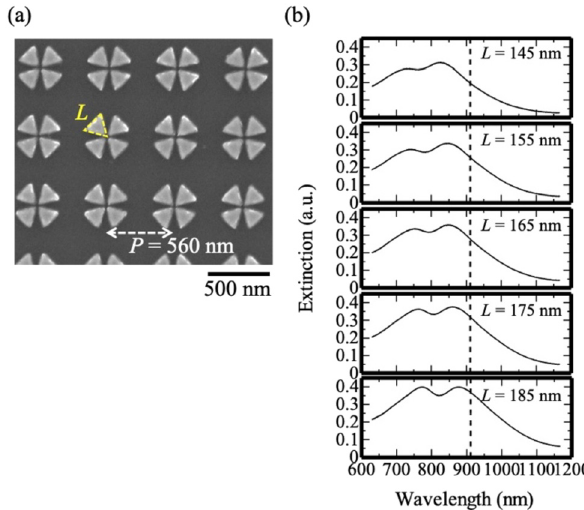
Figure 6: (a) SEM image of the fabricated gold tetramer array. The dimensionsareasfollows: L =185nmand P =560nm.(b)Extinction spectra of the gold tetramer array with L = 145, 155, 165, 175, and 185 nm from the top. The black dotted line indicates the wavelength of 911 nm.